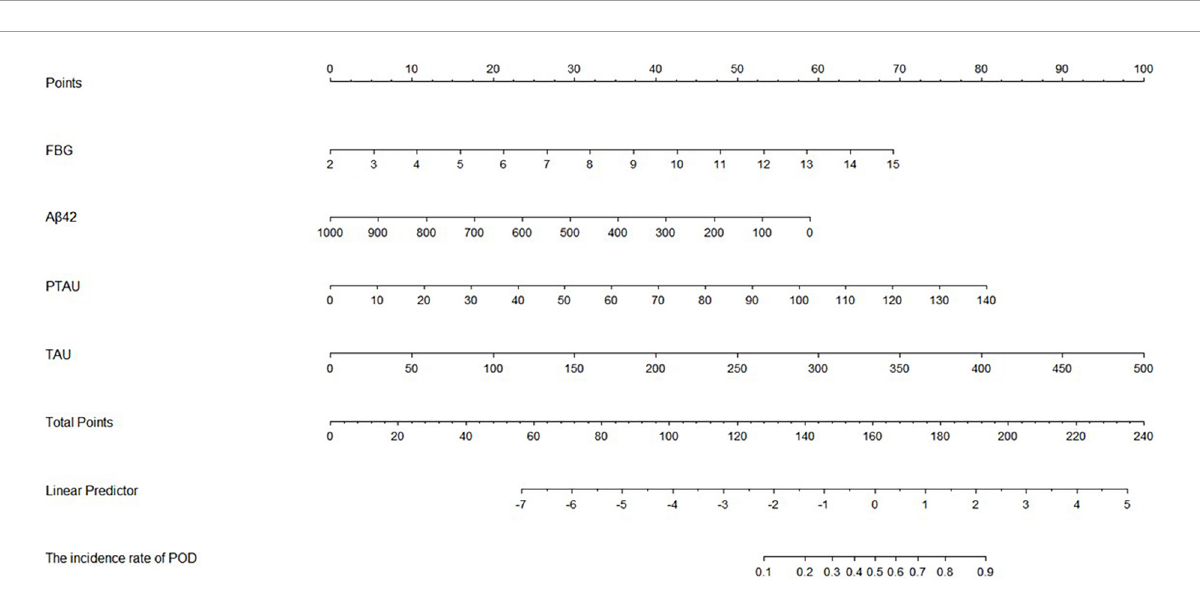
non-diabetic population with the diabetes-like characteristics as described